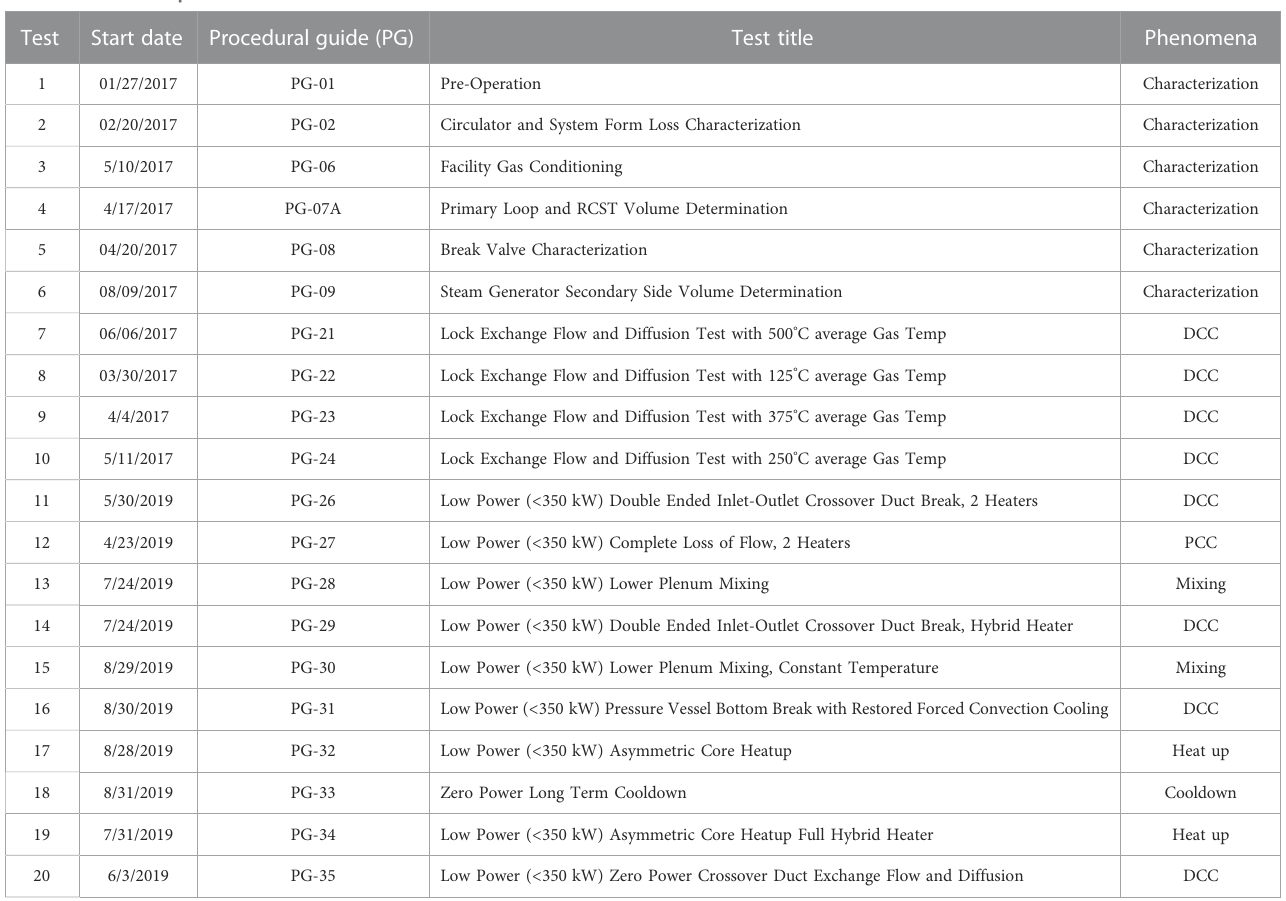
TABLE 1 HTTF- list of performed